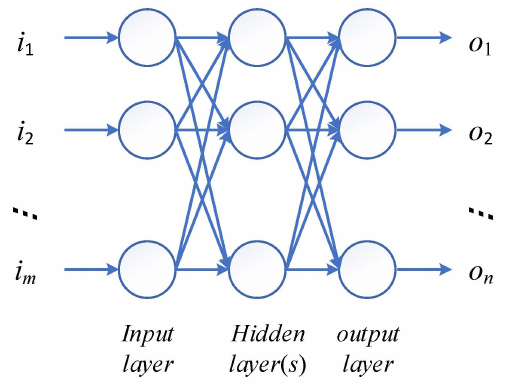
Figure 7. Structure of an